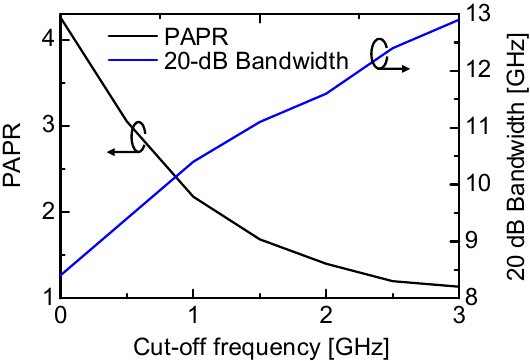
Figure 12. PAPR and 20-dB optical bandwidth of the modulator output signal.